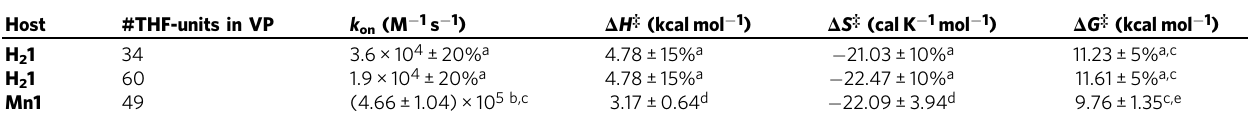
a Values taken from refs. 40, 41 ( k on values measured at 23°C). k d values can be found in Tables S10 and S11. b The k on values were calculated from K a ¼ k on k d ; c Values for T = 25°C. d Determined from the Eyring plot with calculated k on values over the temperature range 20 – 70°C, assuming that the K a of Mn1 / V1 remains constant over this temperature range. (cid:1) (cid:3) e Calculated from Δ G z ¼ (cid:3) RTln k on h k in which R , h , k B are the ideal gas constant, the Planck constant, and the Boltzmann constant,